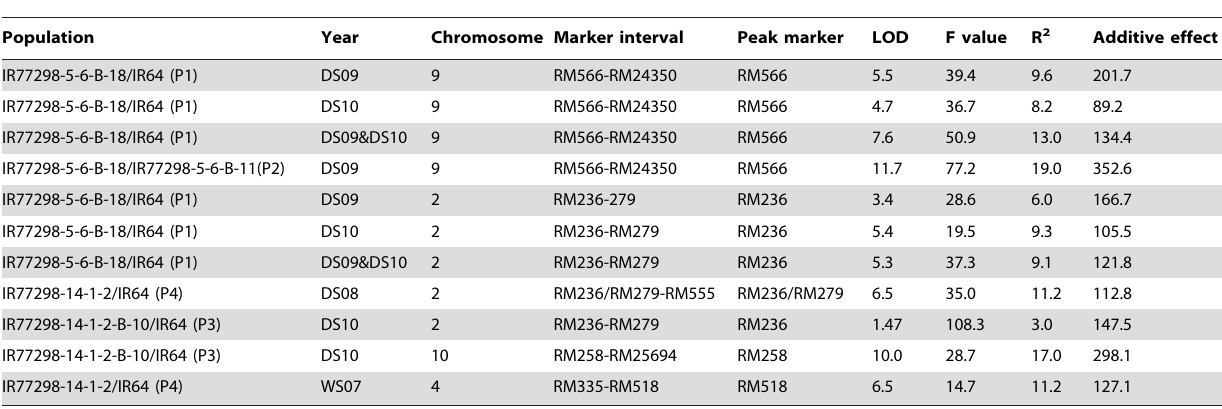
Table 1. QTL for grain yield under drought in IR64 6 Aday Sel derived populations.